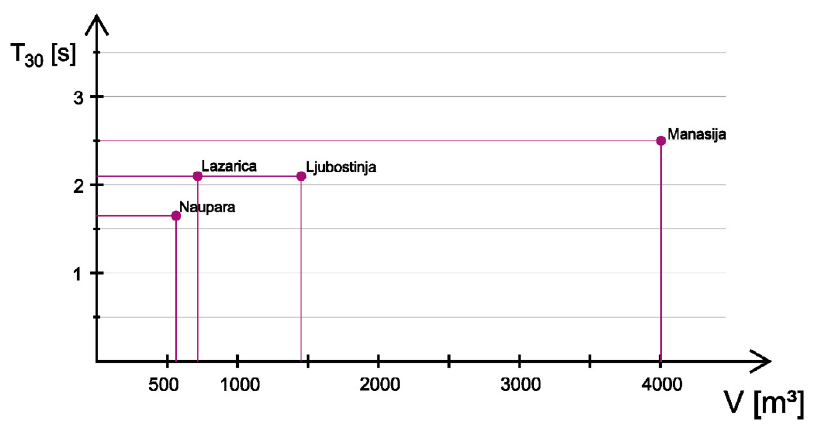
Figure 5. Graph showing a comparison of the Reverberation Time in relation to the total church volume for four churches built in the Morava architectural